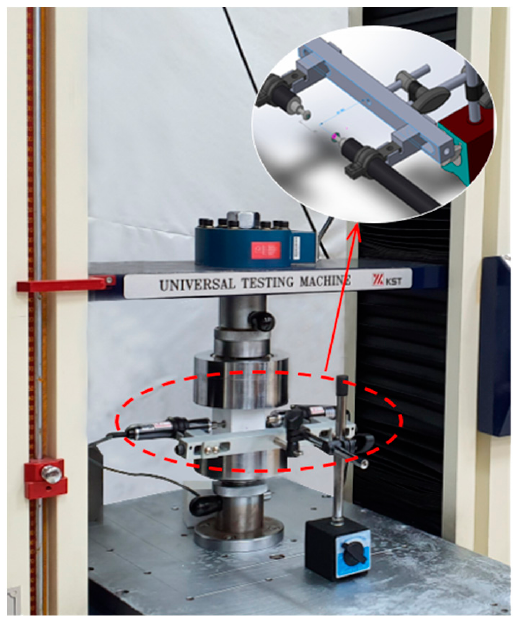
Figure 3. Universal testing machine, with a lateral strain-measuring device for EPS specimens.